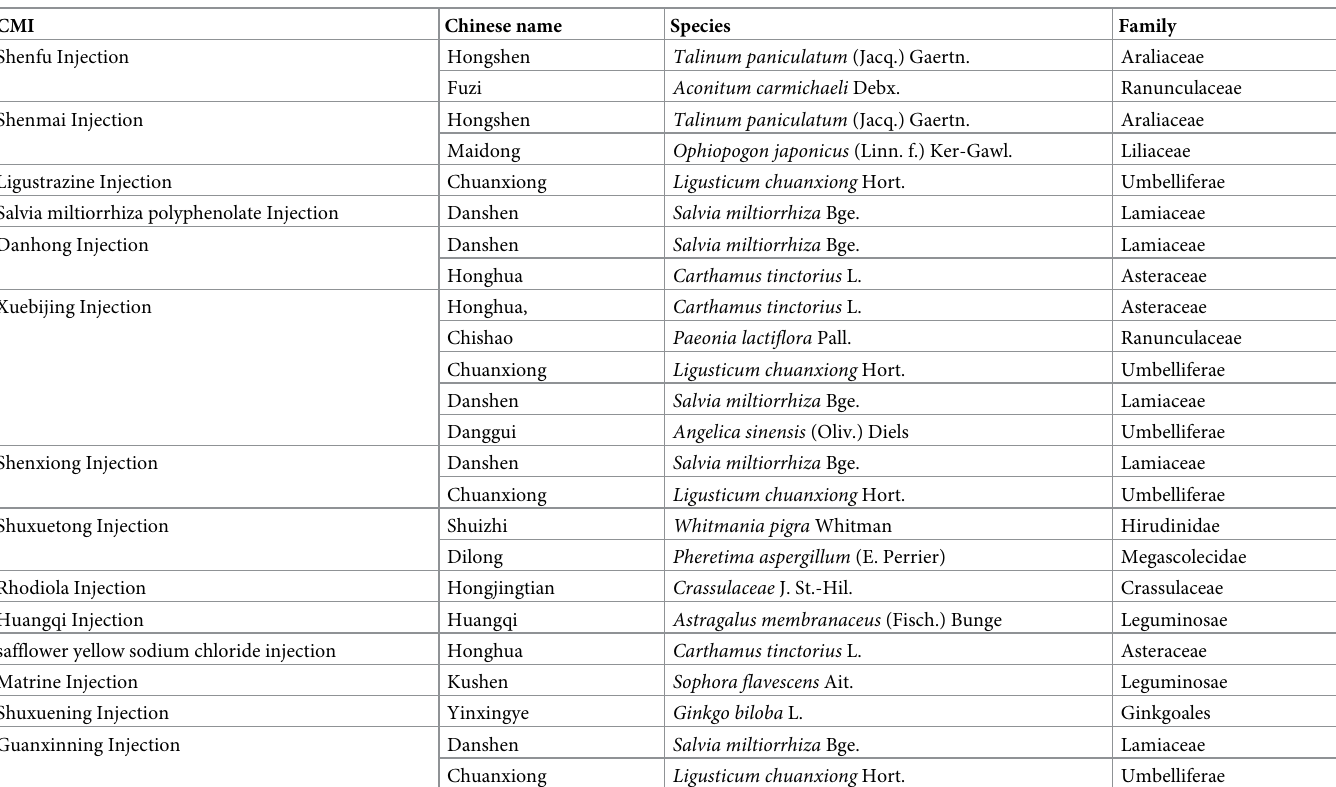
Table 1. Components of